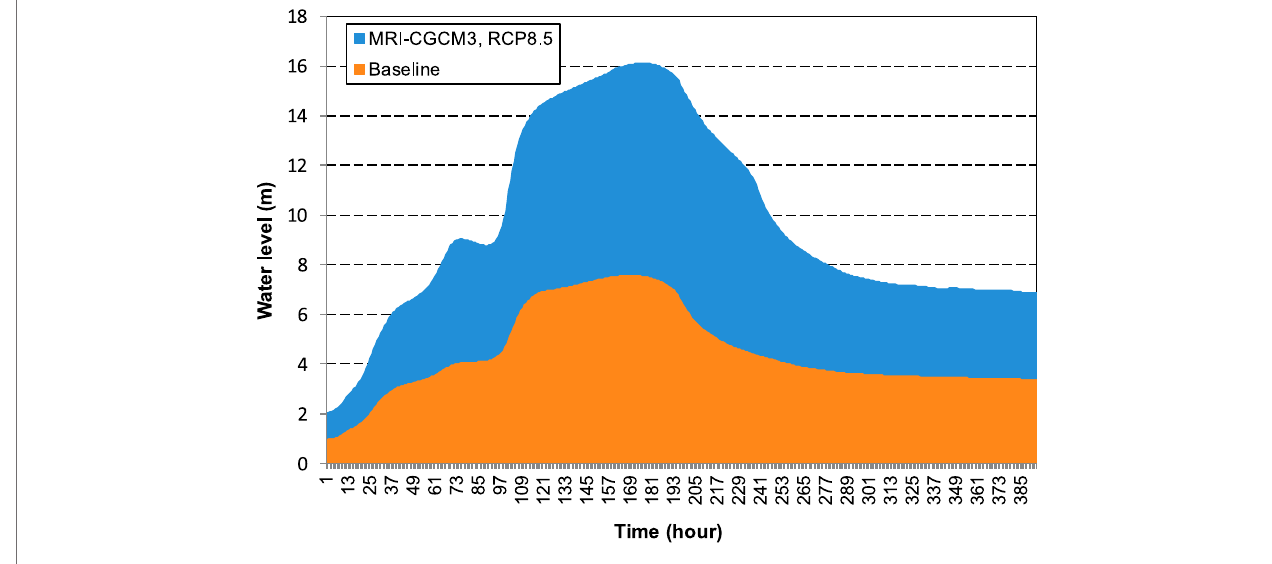
FIGURE 8 | Comparison of water level in the baseline period and in 2050s.